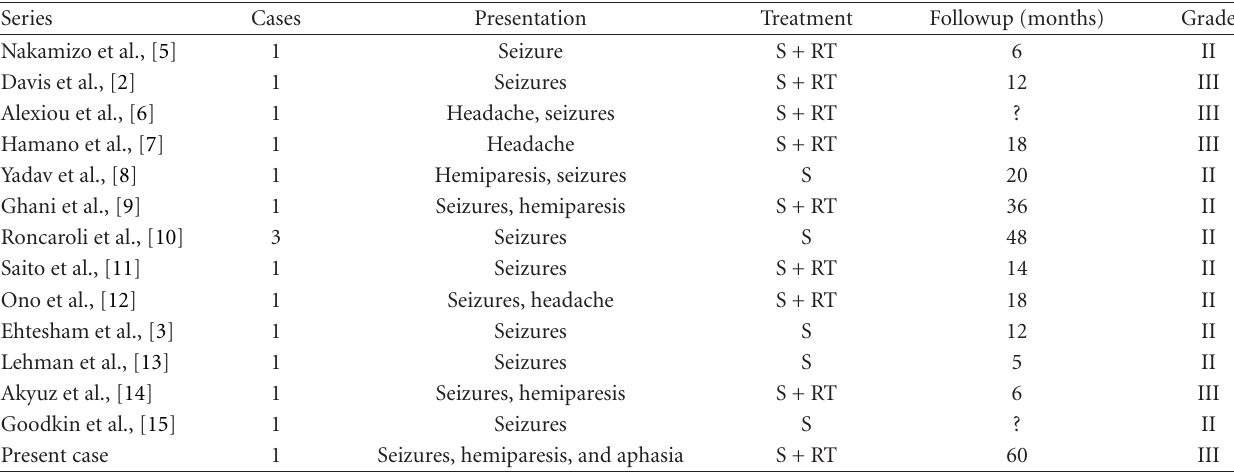
Table 1: All reported cases of pure cortical supratentorial ependymomas.